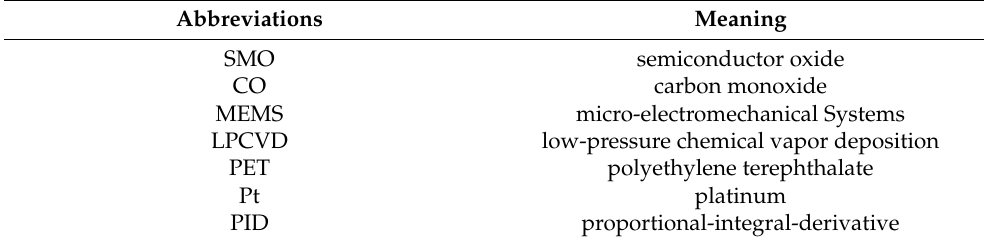
Table 2. List of abbreviations used in this